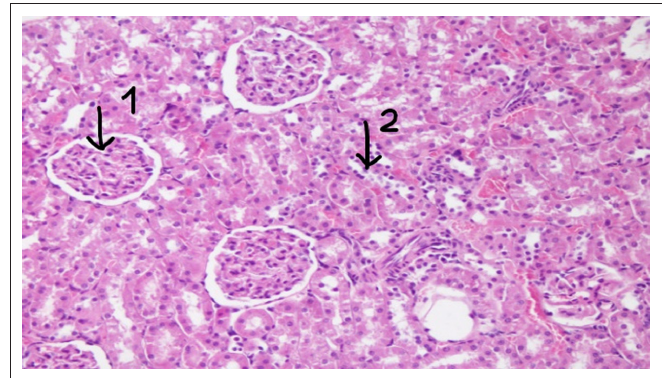
Figure 1. Light microscopic view of the kidney of the control group, where glomeruli (arrow 1) and tubule (arrow 2) structures are seen (H&E, × 200). H&E, hematoxylin and eosin.